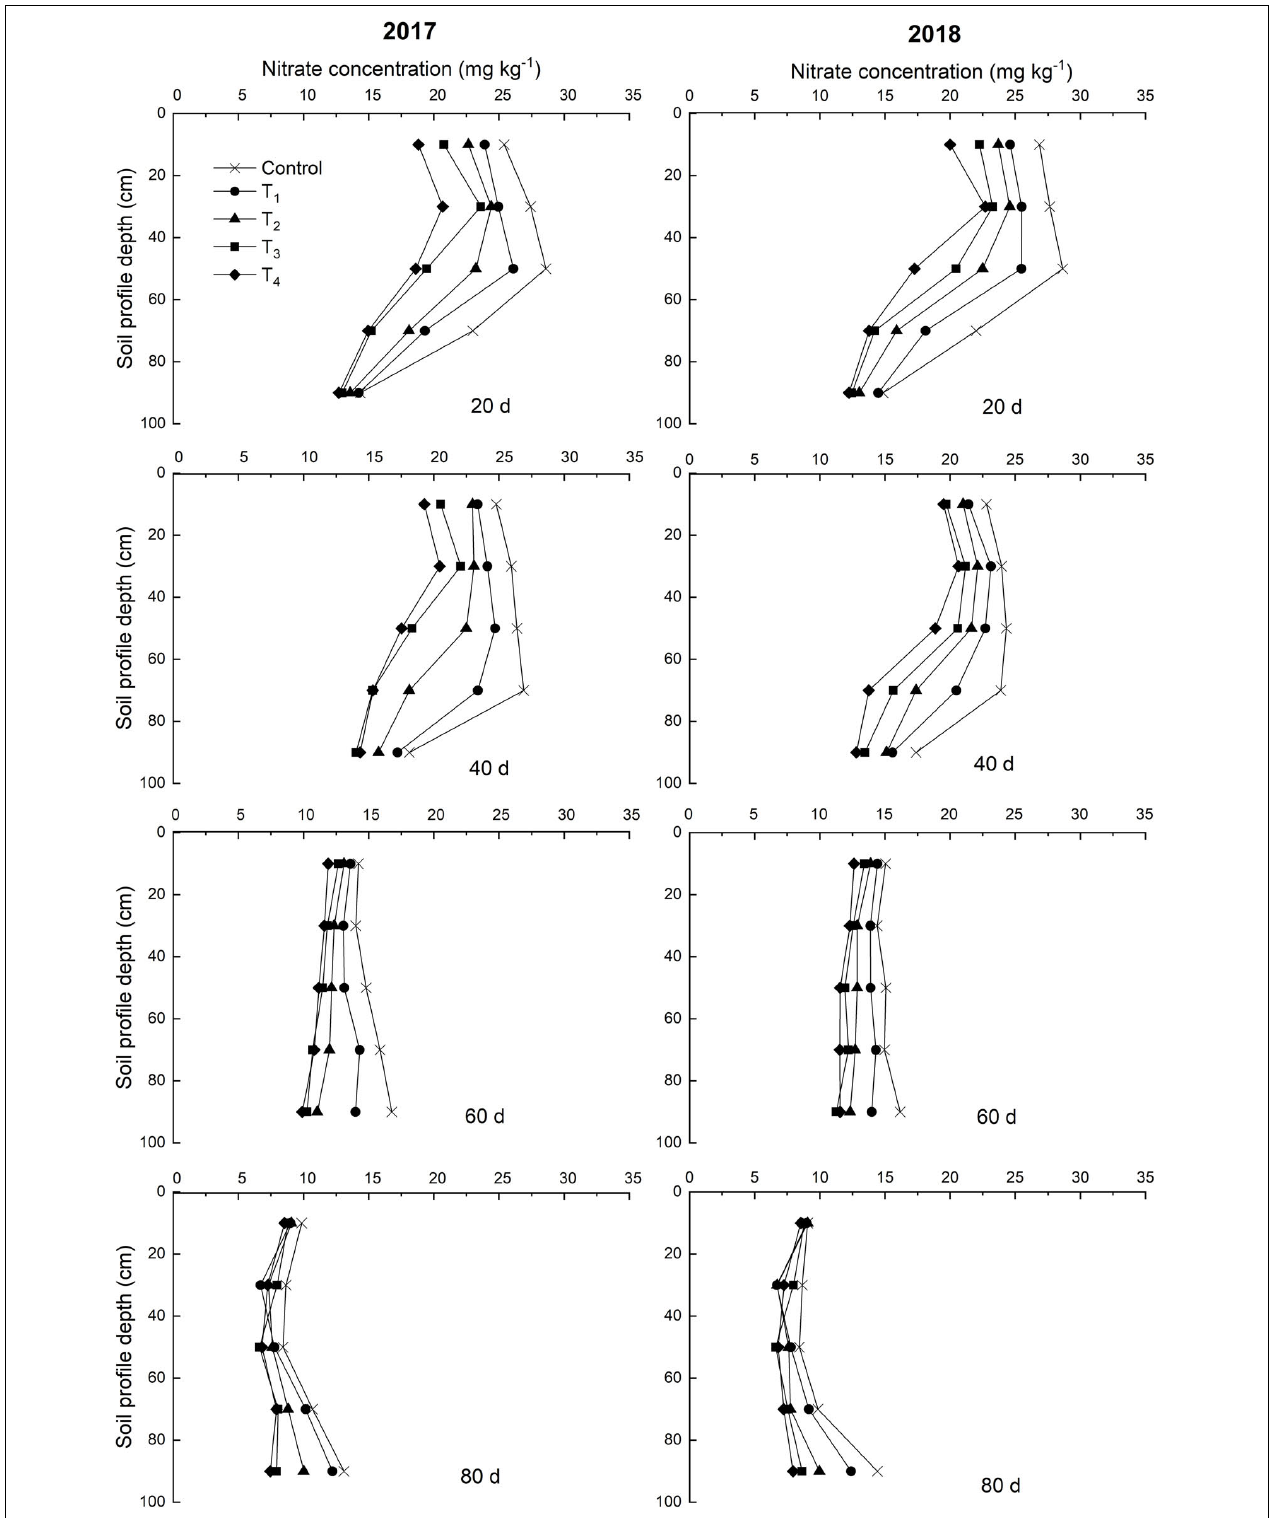
FIGURE 4 | Effects of DMPP on the dynamic of NO 3 − -N concentration of soil in 2017 and 2018.